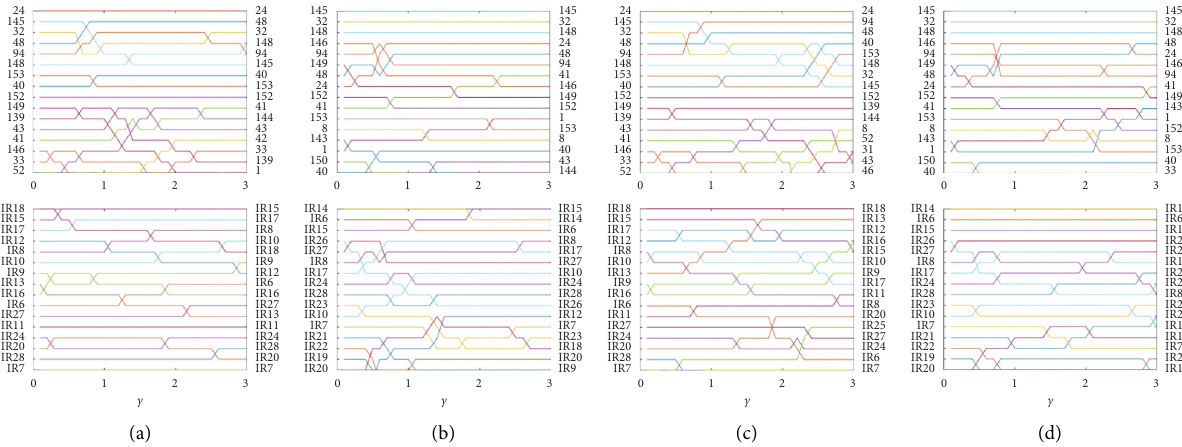
Figure 22: Multiplex MultiRank calculations on the full dataset. The first row corresponds to the node’s ranking and the second one to the layers. Every graph shows the results for the parameter c between 0 and 3. (a) Elite layers have more weight and the influence of each layer is required to be independent of W α . (b) Elite layers have more weight and centralities of the layers are not normalized by W α . (c) Popular layers are more influential and this influence is independent of W α . (d) Popular layers are more influential and centralities are not normalized by W α